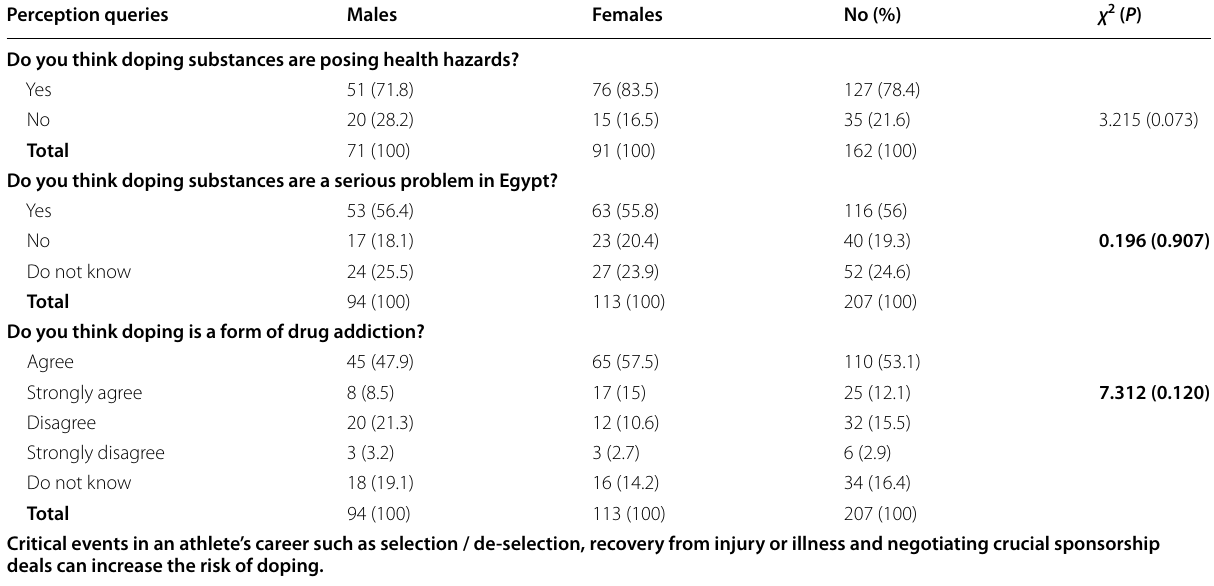
Table 5 Perception of performance-enhancing substances: hazards and sanctions Perception queries